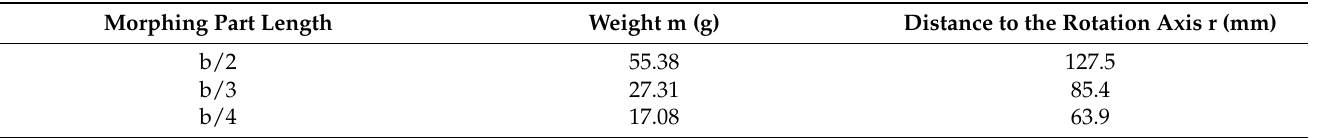
Table 2. Parameters corresponding to different morphing part lengths.